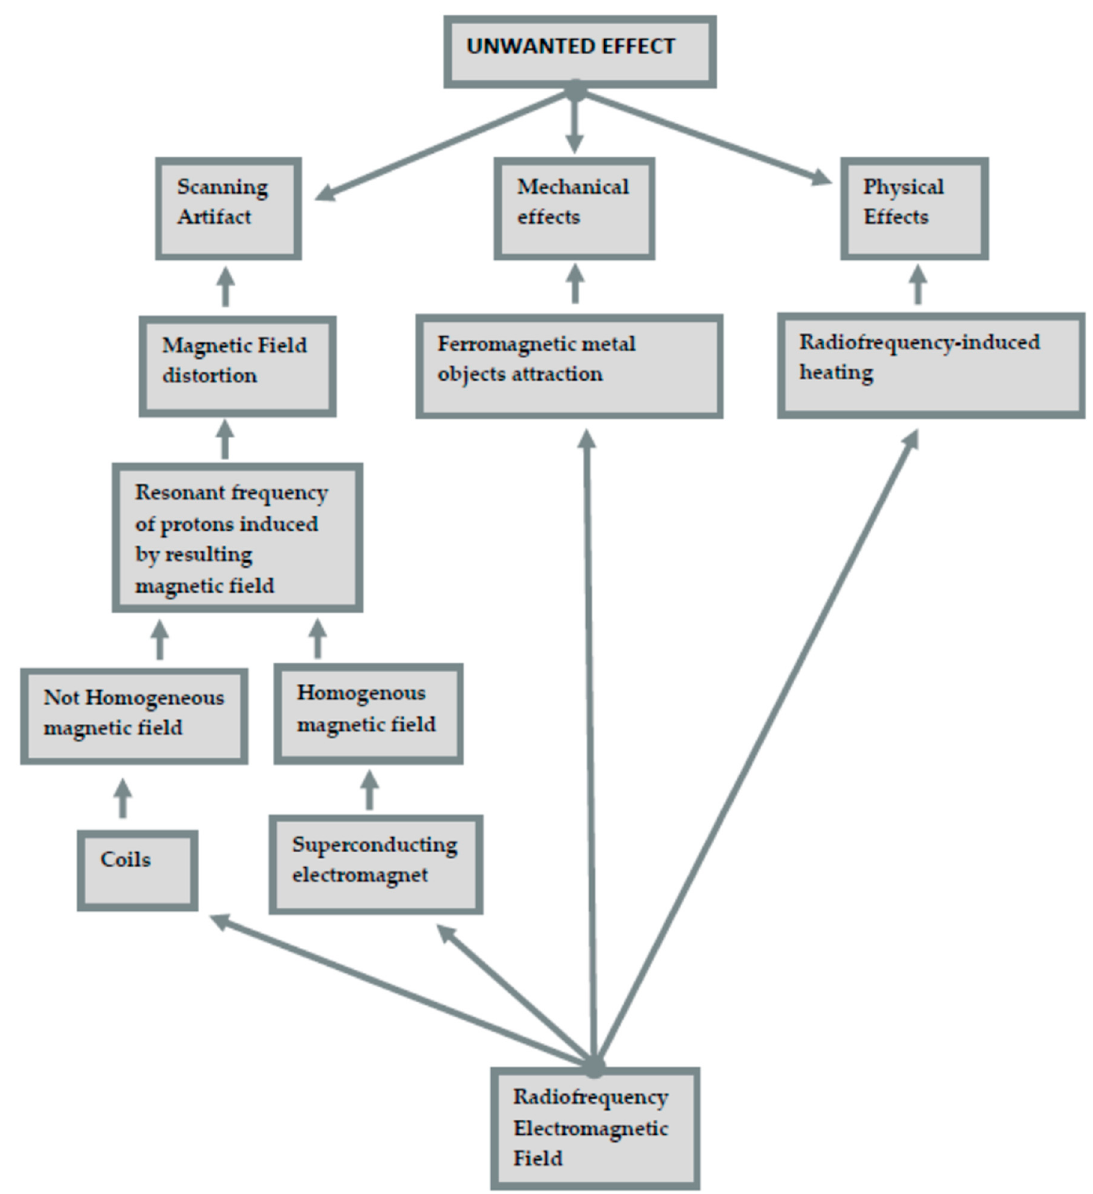
Figure 1. Influence of an electromagnetic field.